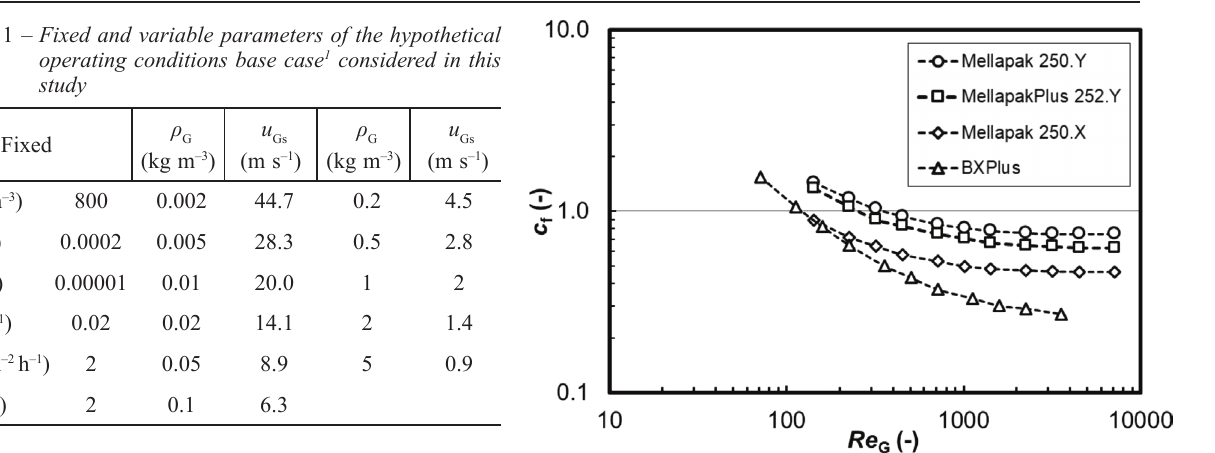
Fig. 1 – Drag coefficient as a function of gas or vapor Reyn- olds number for four representative different types and sizes of Sulzer corrugated sheet structured packings in conjunction with hypothetical operating conditions base case, with fixed values of vapor load, liquid load, vapor viscosity, and liquid properties (see Table 1), considered in this study